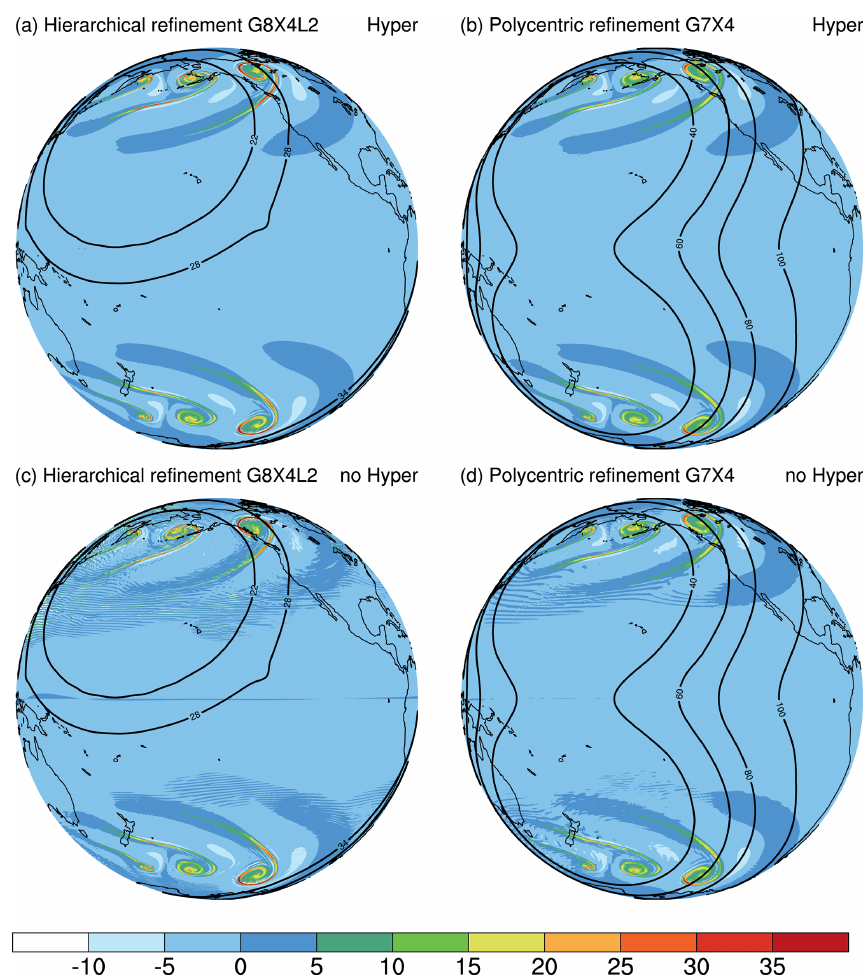
Figure 8. As in Fig. 6, but for two multi-region refinement meshes: (a) a hierarchical refinement style (G8X4L2) and (b) a polycentric refinement mesh based on G7X4. Panels (c, d) are the same as panels (a, b) but are for runs that turn off the hyperdiffusion option. The contour lines denote the smoothed mesh cell sizes (km). Note that the small kink in the 28km contour of (a, c) simply reflects that the generated mesh occasionally has higher local irregularities at some